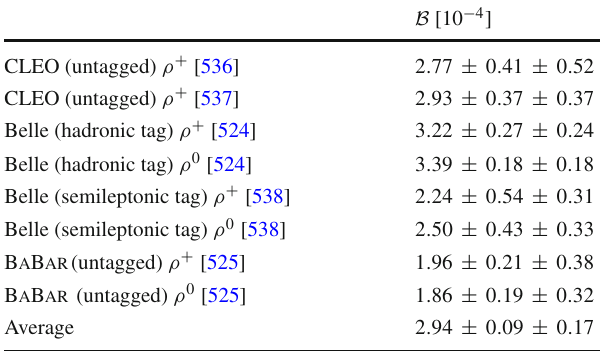
Table 85 Summary of exclusive determinations of B 0 → ρ(cid:12) + ν . The errors quoted correspond to statistical and systematic uncertainties,